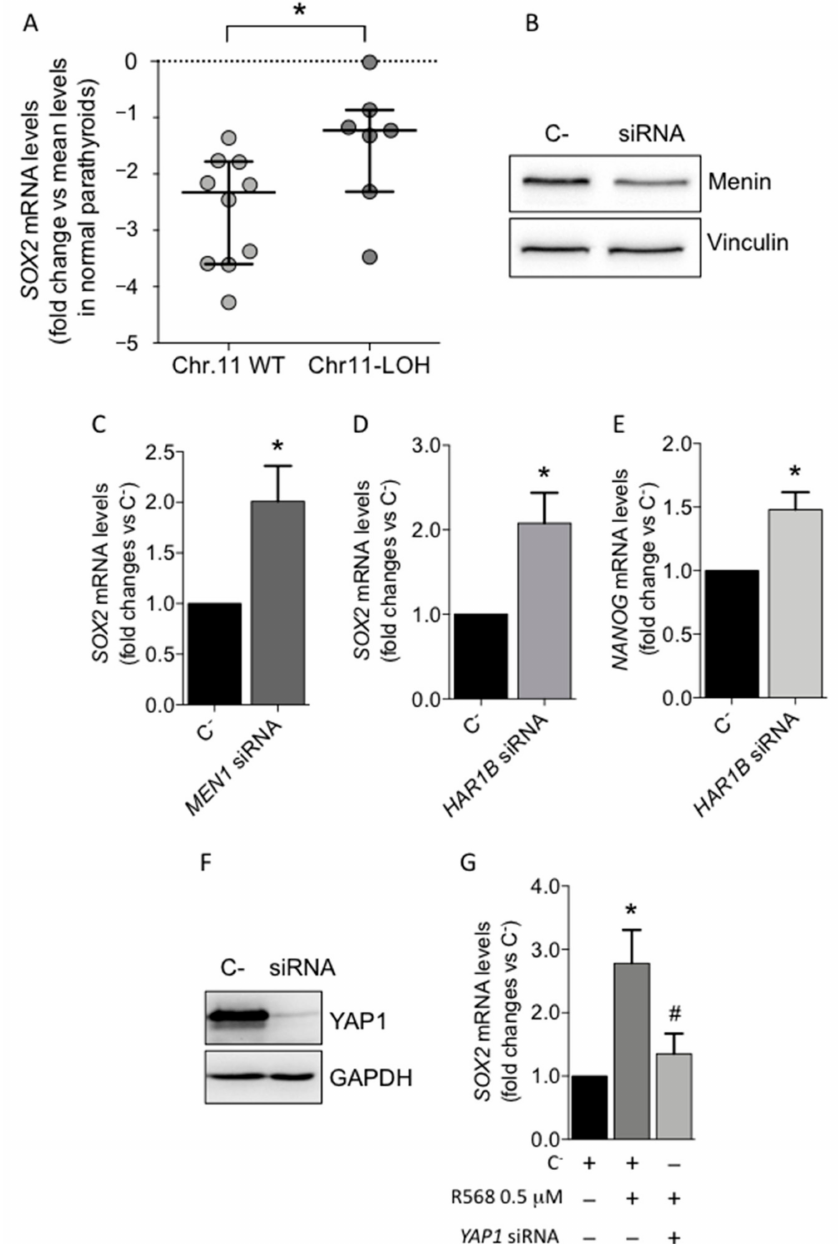
Figure 2. Effect of MEN1 gene silencing and the CASR/YAP1 activated pathway on the expression of the core stem genes in PAds-derived cells. ( A ) SOX2 gene expression levels according to PAds genetic background. Data are presented as log2 fold change with respect of the mean gene expression levels in normal parathyroid glands; bars represent mean and SEM; Chr 11-WT, PAds harboring both copies of chromosome 11; Chr 11-LOH, PAds harboring one copy of the chromosome 11; * p = 0.025. ( B ) MEN1 gene silencing by smart pool siRNAs induced significant reduction of menin protein expression; ( C ) SOX2 mRNA levels after MEN1 silencing in PAds-derived cells; * p = 0.041 by one-way ANOVA adjusted for multiple comparison; data presented as mean ± SEM of four independent experiments. ( D ) Effect of HAR1B silencing on SOX2 mRNA expression levels in PAds-derived cells ( n = 3); ( E ) HAR1B silencing induced significant increases in NANOG mRNA levels. ( F ) YAP1 gene silencing by smart pool siRNAs induced significant reduction of the YAP1 protein expression; ( G ) Effect of CASR activation on SOX2 expression after 0.5 µ M R568 treatment, with or without YAP1 transient silencing in PAds-derived cells ( n = 3). C-, PAds-derived cells treated with negative control siRNA; MEN1 siRNA, PAds-derived cells treated with specific siRNA against MEN1 ; HAR1B siRNA, PAds-derived cells treated with specific siRNA against HAR1B ; YAP1 siRNA, PAds-derived cells treated with specific siRNA against YAP1 ; * p = 0.036; # p =